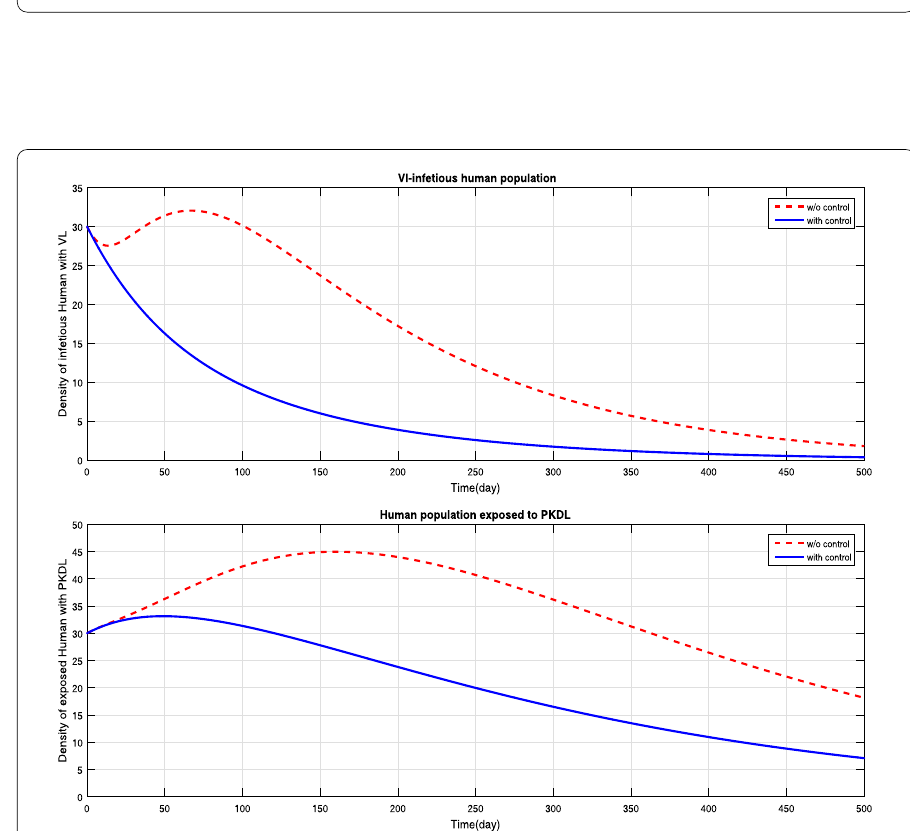
Figure 4 Comparison of behaviors with and without control in case of I 2 and E